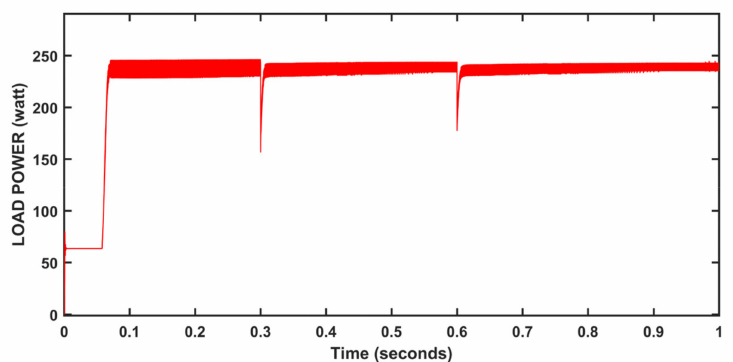
Figure 27. Output power of NN system at variable loads and constant irradiation and temperature.